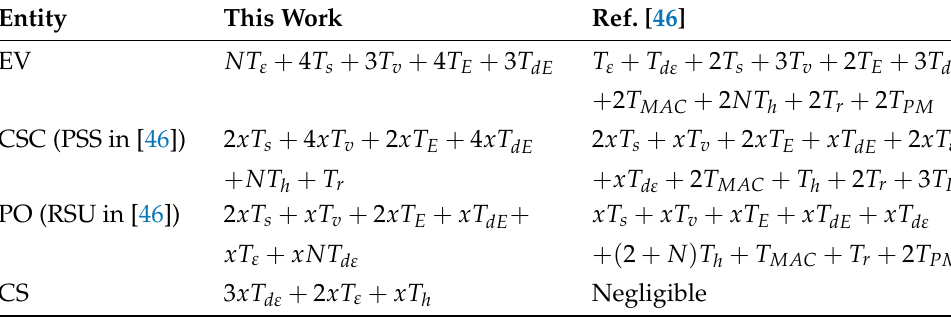
Table 3. Computational cost calculation for each network